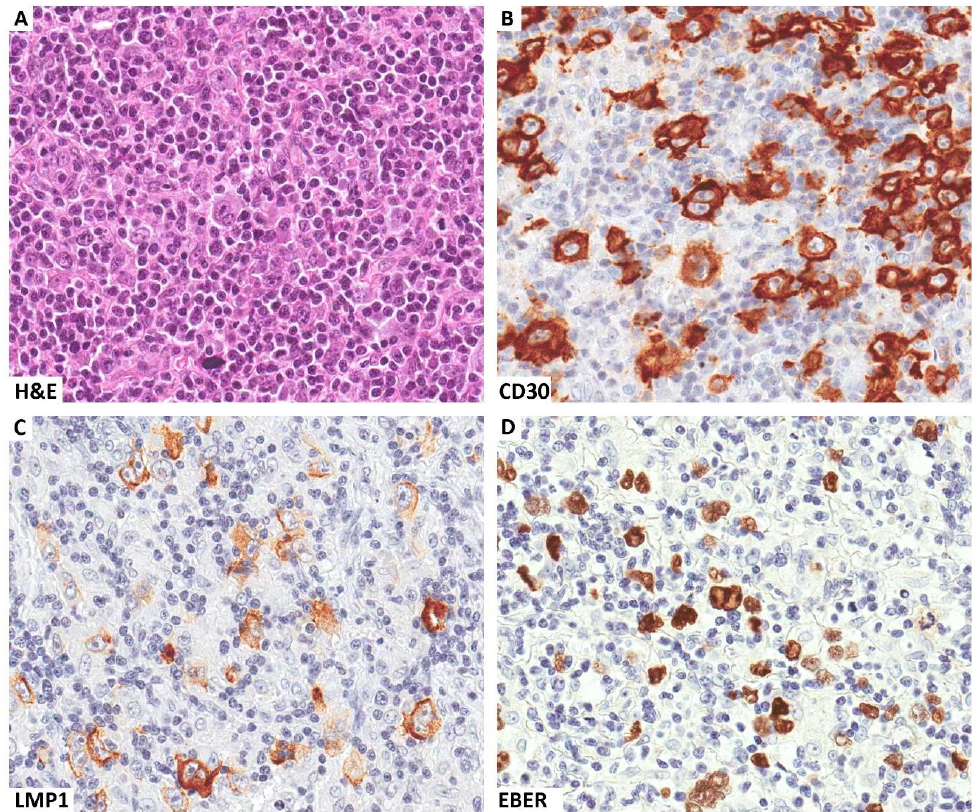
Figure 1. A clinical case of EBV-related Hodgkin lymphoma occurring in a patient with HIV